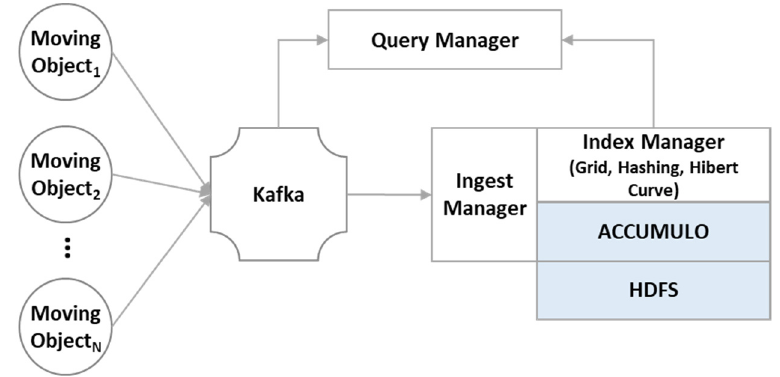
Figure 3. Architecture of the proposed parallel spatiotemporal data ingestion method.